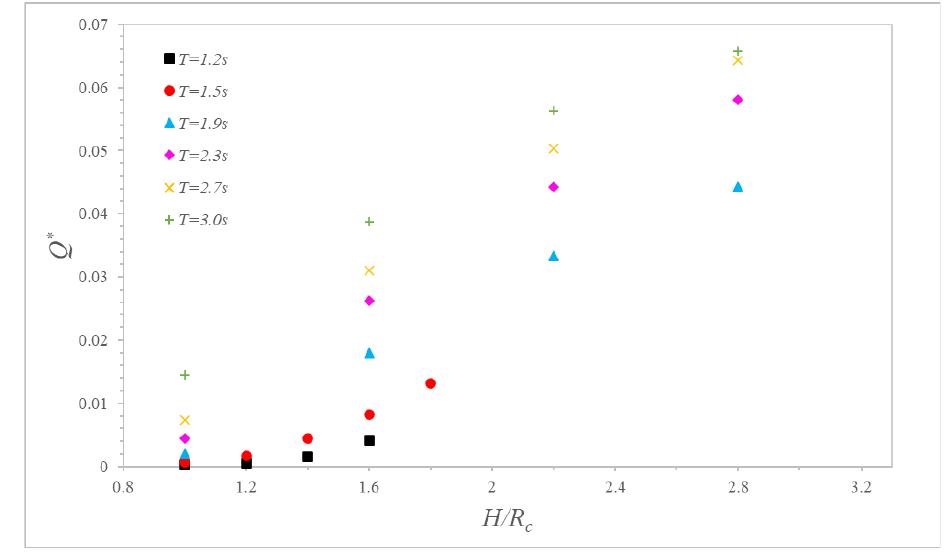
Figure 11. Relationship between dimensionless parameter H/R c and Q* .